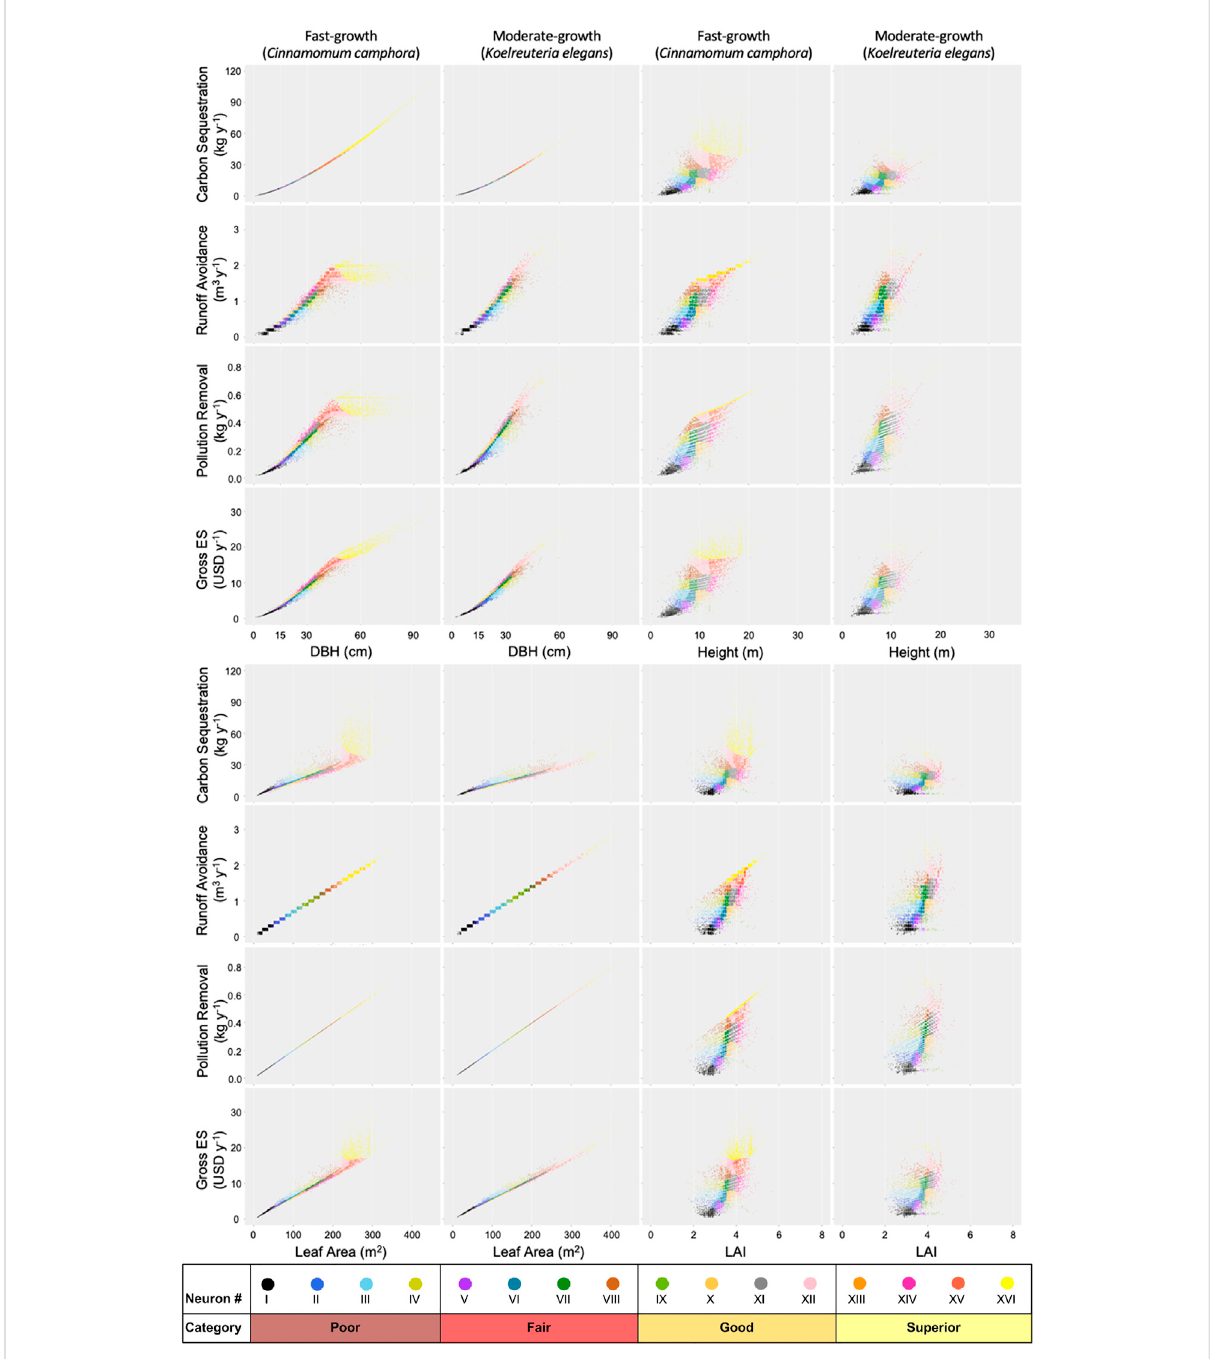
FIGURE 4 Based on the SOM, we used Cinnamomum camphora (a fast-growth species) and Koelreuteria elegans (a moderate-growth species) as examplestoshowtheindividualspecies ’ associationsofDBH,height,leafarea,andLAItocarbonsequestration,pollutionremoval,runoffavoidance, and gross ES by scatter